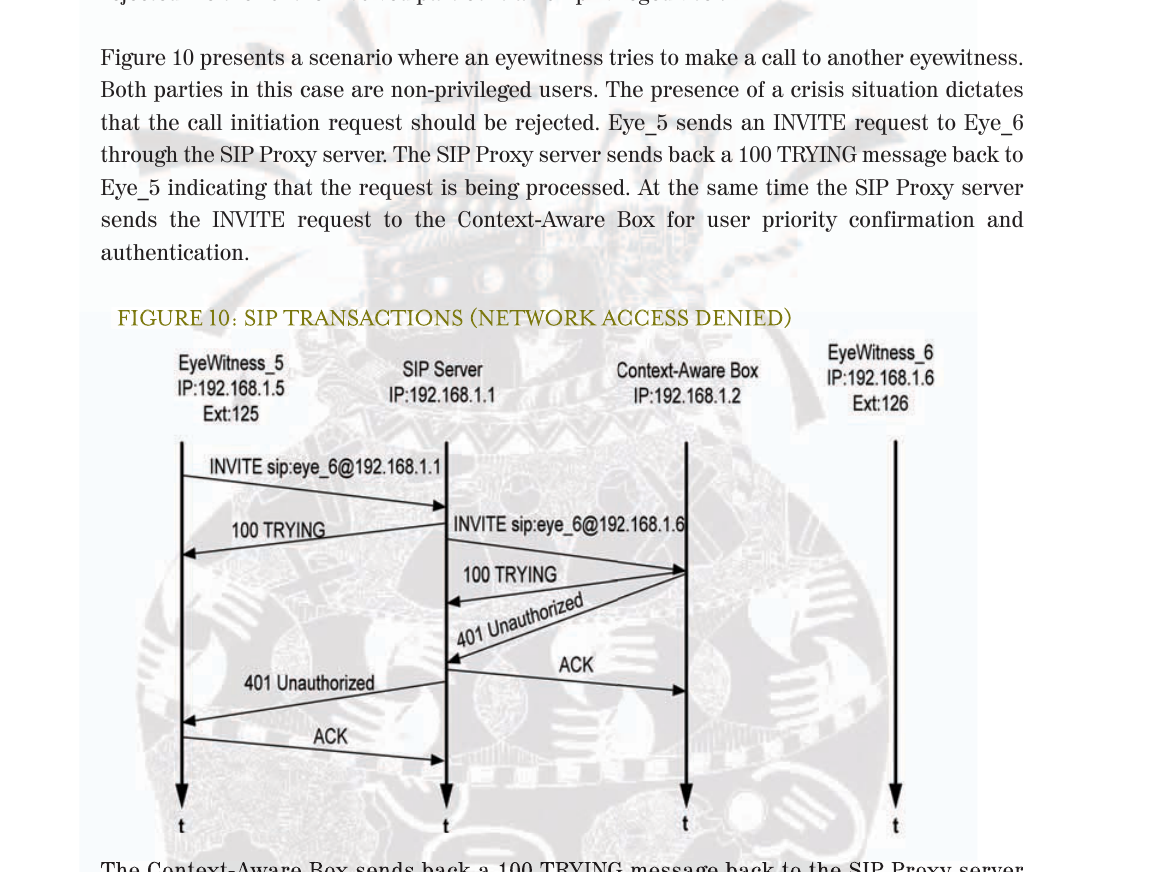
FIGURE 10: SIP TRANSACTIONS (NETWORK ACCESS DENIED)